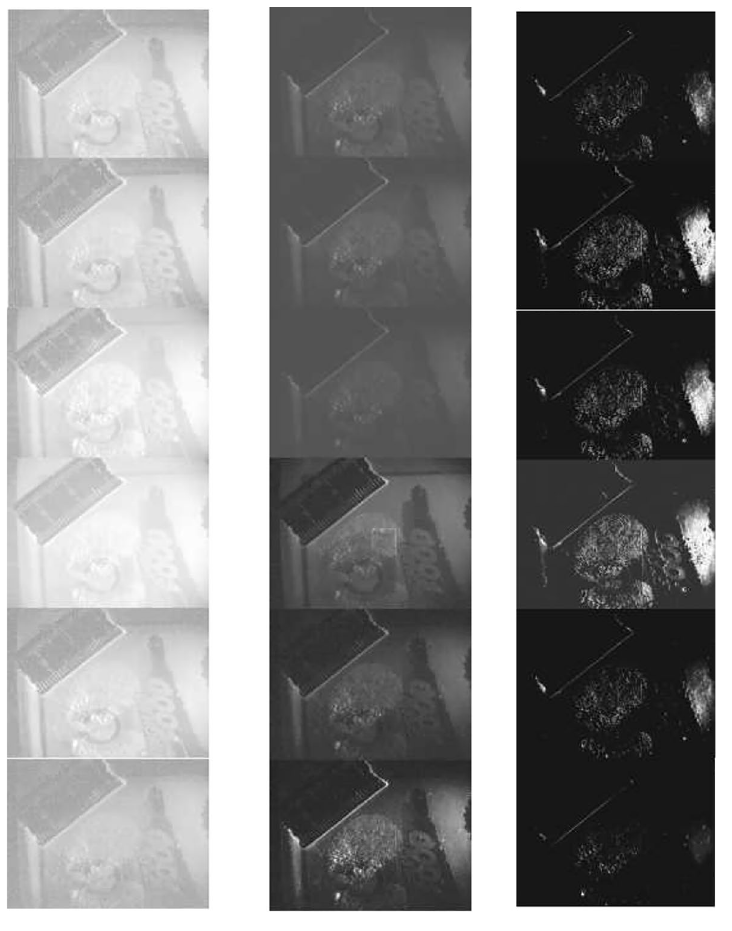
Figure 10. Example of three image sets using one light distribution angle.